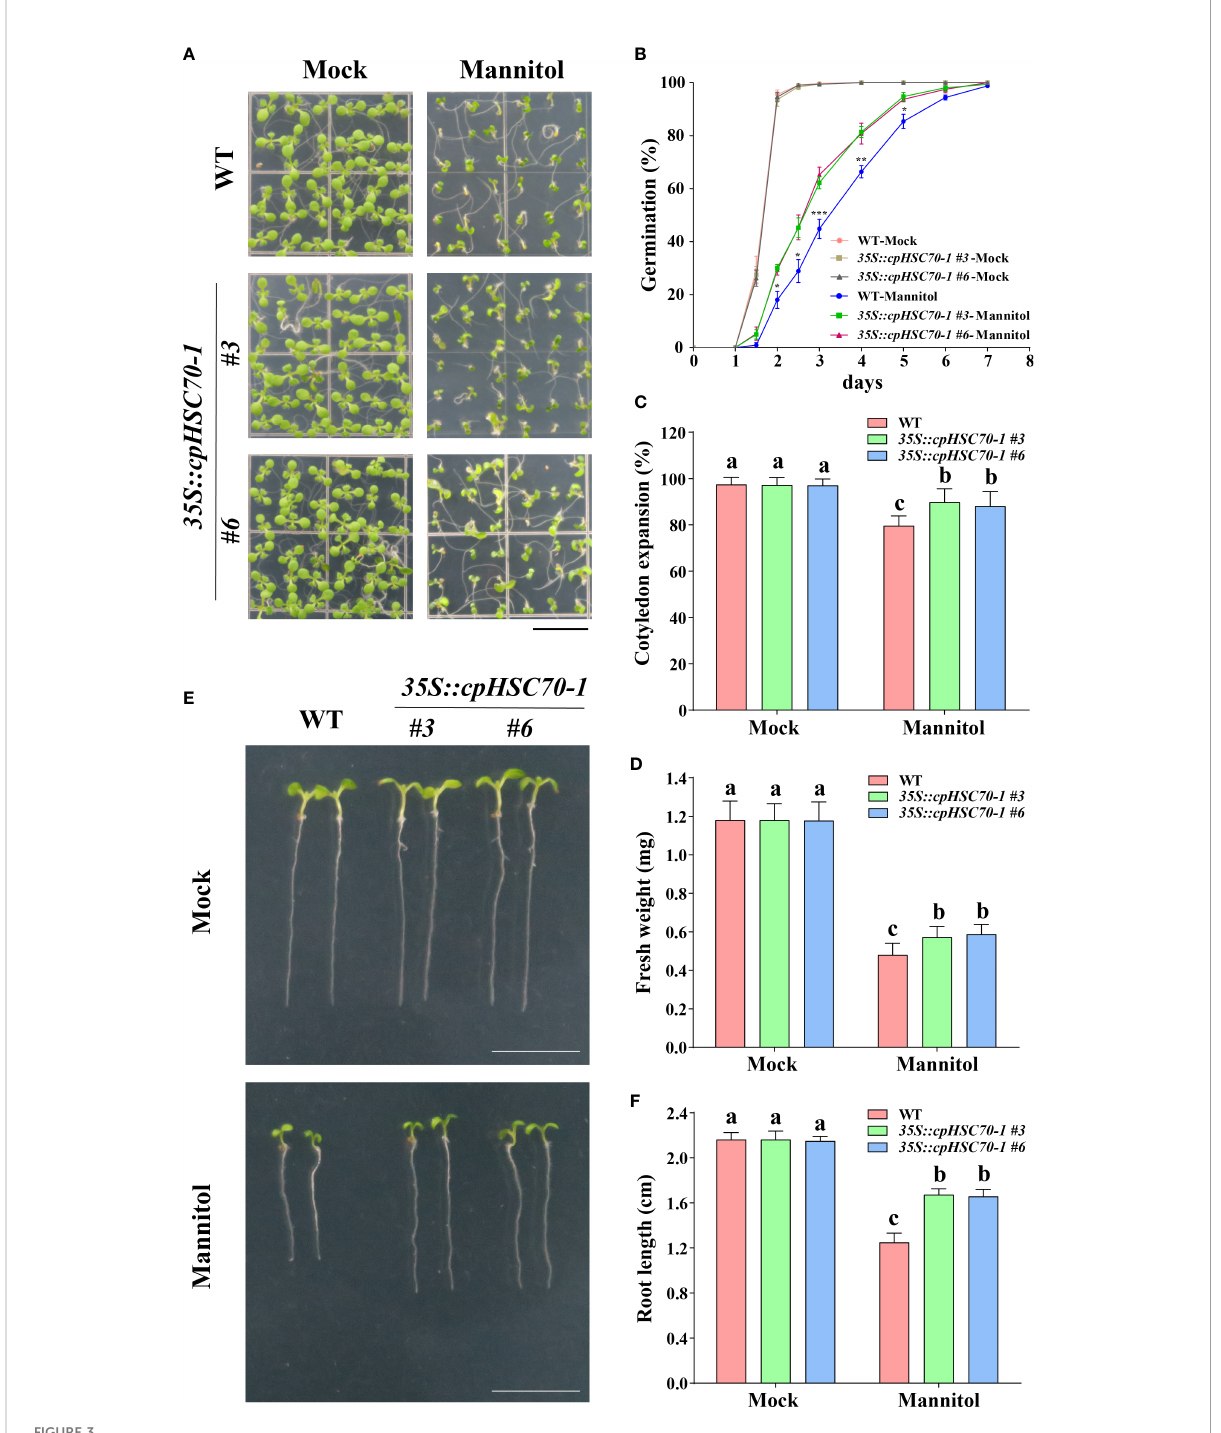
FIGURE 3 Overexpression of cpHSC70-1 enhanced osmotic stress tolerance. (A) Images of 5-day-old wild-type and 35S::cpHSC70-1 seedlings grown on 1/2 MS medium with or without (Mock) 300 mM mannitol. Bars = 1 cm. (B) Germination rate of the wild-type and 35S::cpHSC70-1 plants in response to 300 mM mannitol. (C) Rate of cotyledon expansion and (D) fresh weight of wild-type and 35S::cpHSC70-1 plants in panel (A) . (E) Images of 5-day-old wild-type and 35S::cpHSC70-1 seedlings grown on 1/2 MS medium with or without (Mock) 300 mM mannitol. Bars = 1 cm. (F) Root length of the plants shown in (E) . The data are means ( ± SD) from at least three independent experiments (n ≥ 60 for germination rate and n ≥ 30 for root length). Asterisks indicate signi fi cant differences revealed using a Student ’ s t -test (* p < 0.05; ** p < 0.01; *** p < 0.001). Different letters indicate signi fi cant differences as determined using ANOVA followed by Tukey ’ s test ( p <